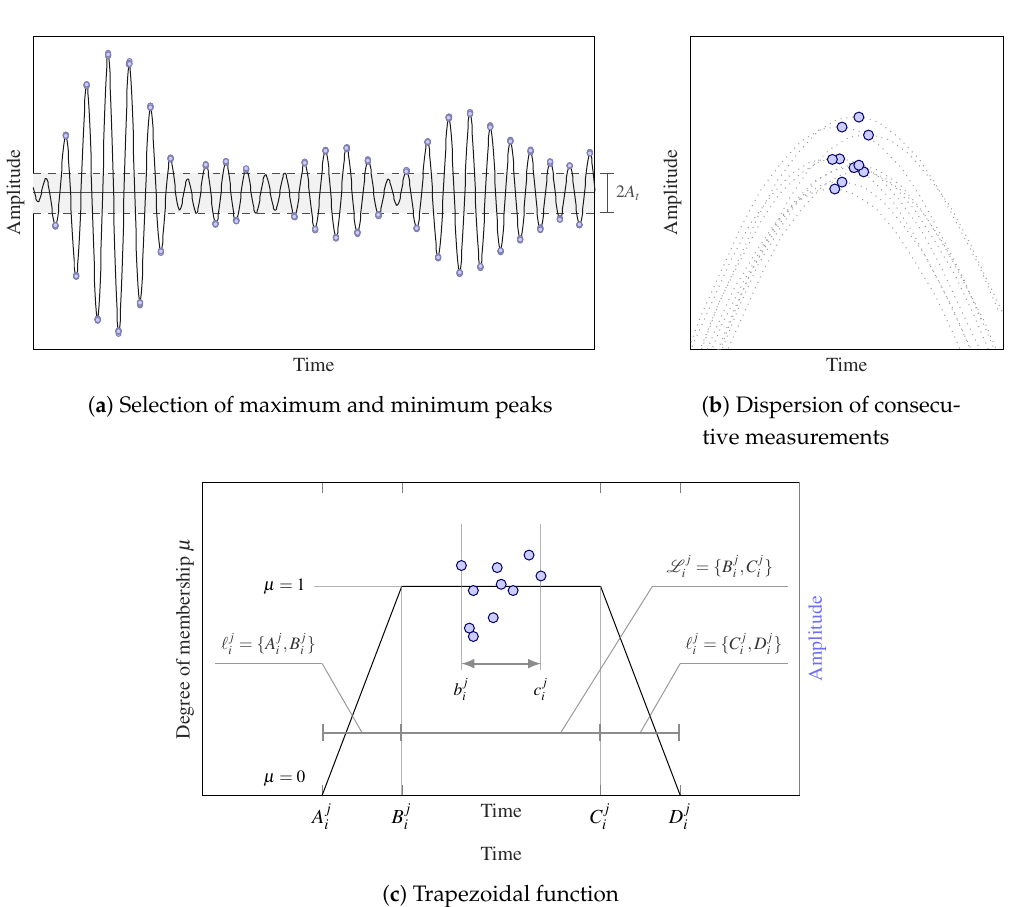
Figure 1. Panel ( a ): Selection of characteristic points (CPs) above the threshold value A t . Panel ( b ): Illustration of ToF dispersion due to repeated measurements. Panel ( c ): Trapezoidal function used to evaluate the ToF mismatch based on the repeated measurements of one CP (blue